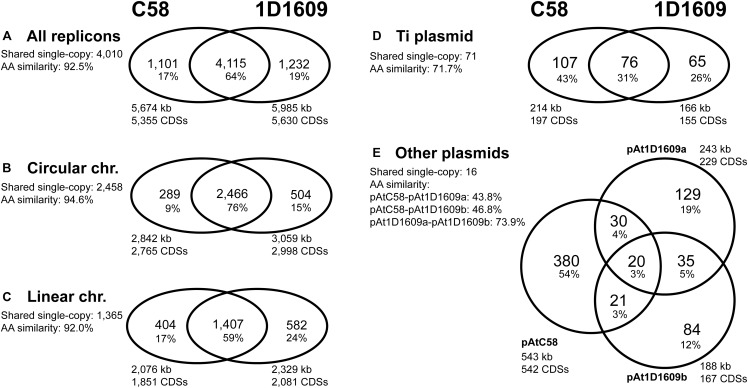
Numbers of shared and strain-specific homologous gene clusters. The percentages of total are labeled in parentheses below gene cluster counts. (A) Genome-level comparison; including all replicons. (B) Circular chromosome. (C) Linear chromosome. (D) Ti plasmid. (E) Other plasmids. The number of shared single-copy genes in each comparison, as well as the average amino acid similarity of these genes, are provided. Additionally, the replicon sizes and the numbers of coding sequences (CDSs) are labeled.